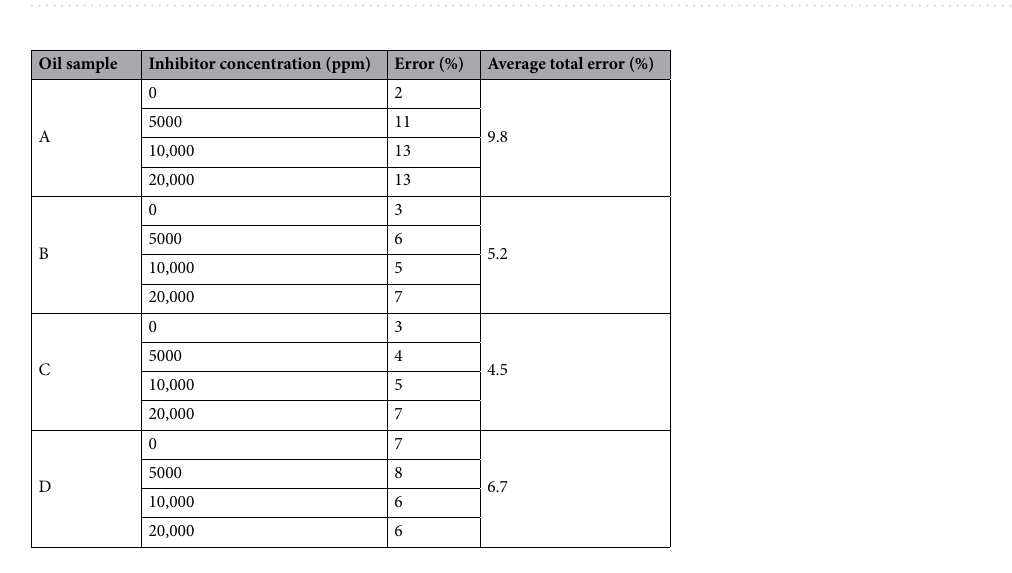
Table 9. Calculated errors for different modes of modeling.